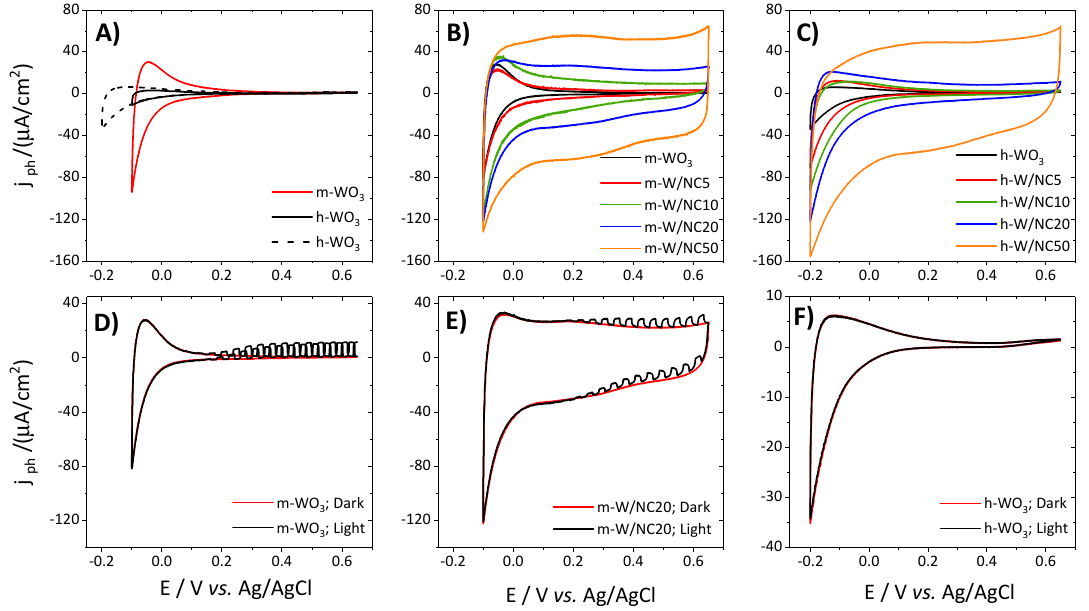
Figure 3. Cyclic voltammograms recorded at 20 mV/s of WO 3 and WO 3 /carbon electrodes under ( A – C ) dark conditions and ( D – F ) and square-wave light perturbation at 371 nm (black line) for selected electrodes: ( D ) m-WO 3 , ( E ) m-W/NC20 and ( F ) h-WO 3 . For the potentials expressed vs. NHE refer to Figure S4.